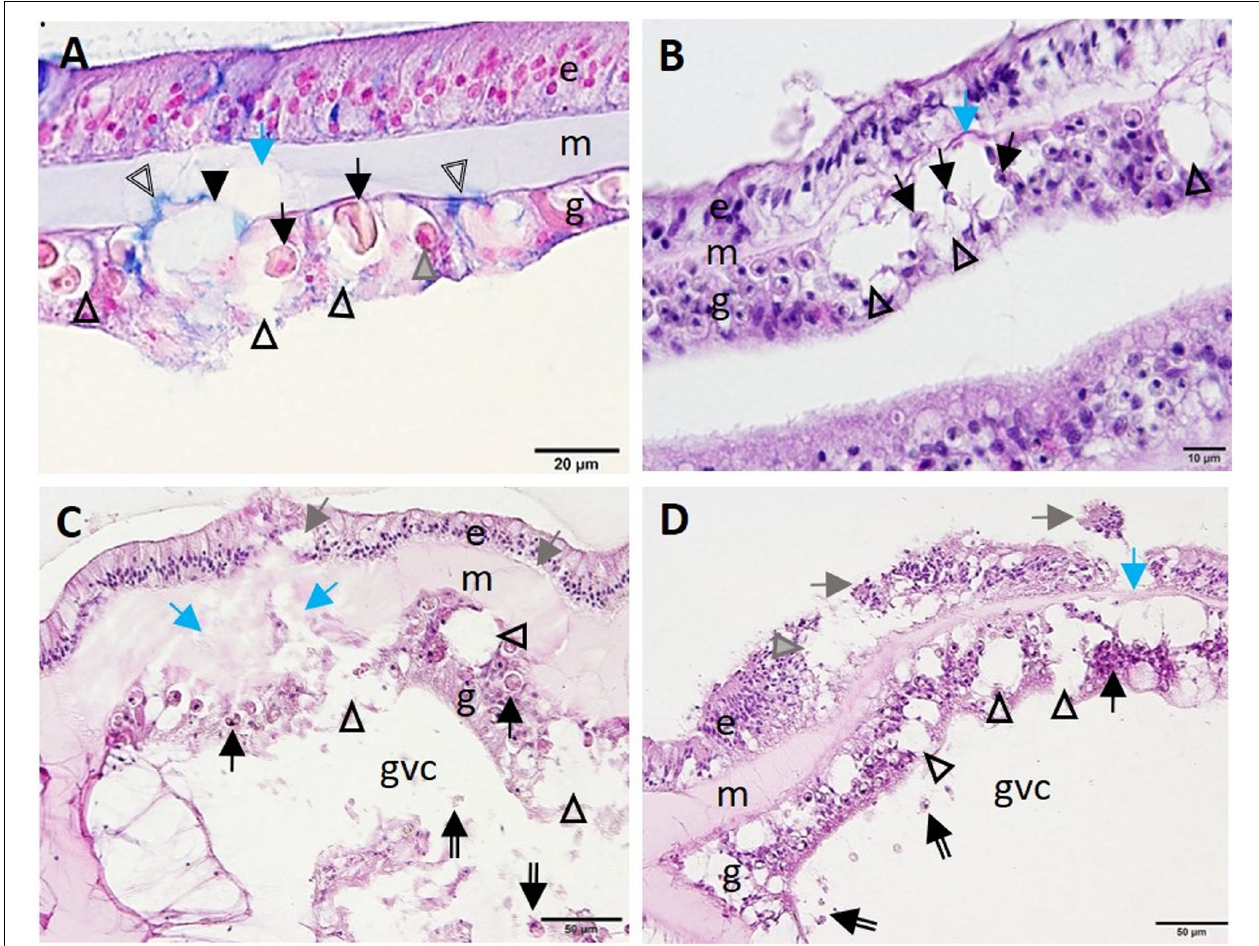
FIGURE 9 | Advance of lytic necrosis (LN) in the surface body wall. (A) Gastrodermis of Montastraea cavernosa manifesting early-stage LN. Note markedly deformed zooxanthellae (arrows), some of which are shrunken, with hypereosinophilic cytoplasm (gray arrowhead) surrounded by greatly expanded symbiosomes (open arrowheads) disrupting hypertrophic mucocytes (indicated by blue-stained area, double-line arrowheads), the cellular architecture of the gastrodermis (closed arrowhead), and the mesoglea (blue arrow). (B) Meandrina meandrites manifesting progressive LN in the gastrodermis. Note large coalescing vacuoles disrupting cellular gastrodermal architecture (arrowheads) with necrotic zooxanthellae (black arrows) and collapse of the mesoglea (blue arrow). (C) Montastraea cavernosa manifesting progressive expansion of LN toward the surface epidermis. Note fragmented and necrotic gastrodermis (arrowheads) with necrotic zooxanthellae (arrows) and fragmented mesoglea (blue arrows) eith cellular debris in the gastrovascular canal (double-line arrows), mesogleal swelling and breached epidermis (gray arrows). (D) Colpophyllia natans manifesting lesion progression. Note marked vacuolation and disruption of gastrodermal architecture (arrowheads), necrosis (black arrow), cellular debris in the GVC (double-line arrows), collapse of mesoglea (blue arrow), and epidermal sloughing (gray arrows) and vacuolation (gray arrowhead). (A) Alcian blue; (B–D) hematoxylin and eosin (H and E). e, epidermis; g, gastrodermis; gvc, gastrovascular canal; m,